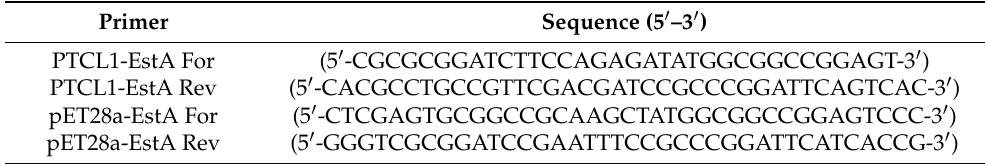
Table 1. Primers used in this